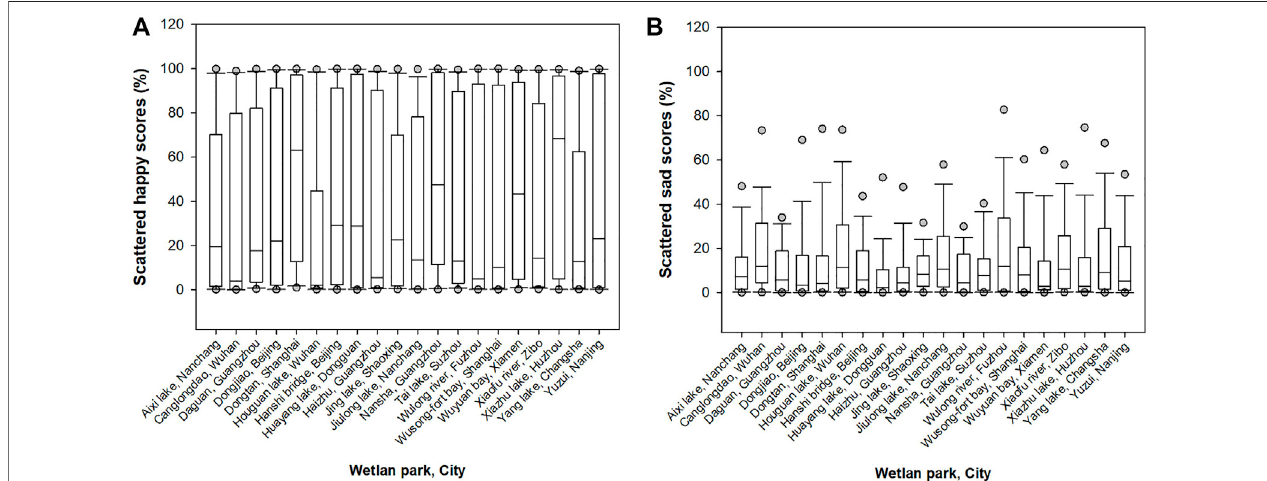
FIGURE2| Whisker – boxplotsforhappy (A) andsad (B) scoresofvisitorsin20urbanwetlandparksattheeasterncitiesofChina.Whiskerslabel95%(upper)and 5%(lower)quartilestobarsatthetopandbottom,respectively;boxendsat75%(top)and25%(bottom)quartiles;dashwithintheboxlabelesthemedianvalueofdatain a city; and scattered dots in gray color label extreme records of raw data with the highest and lowest values at the top and bottom, respectively.